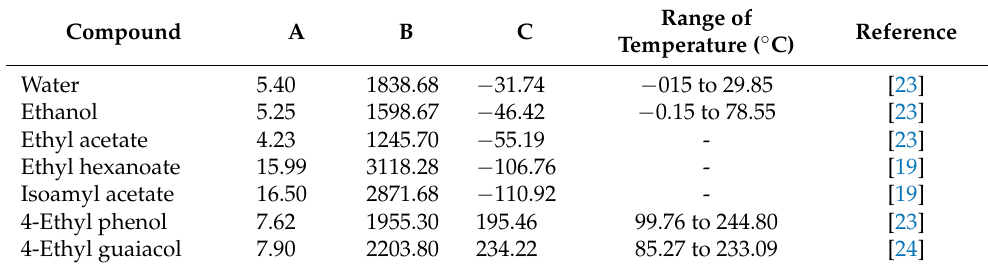
Table 2. Antoine law constants for each compound